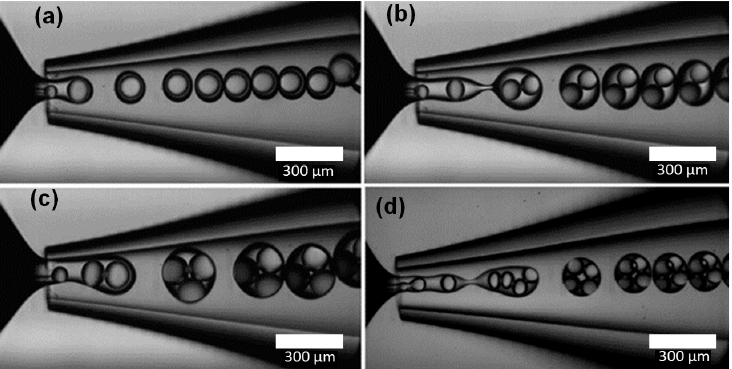
Figure 4. Monodispersed double emulsion with controlled number of inner drops (( a ) One; ( b ) Two; ( c ) Three; ( d ) Four) formed in co-flow/flow focusing geometry within glass capillary device at different fluid flow rates. Reproduced with permission from Lee et al. [101], publisher by Wiley-VCH, 2009.